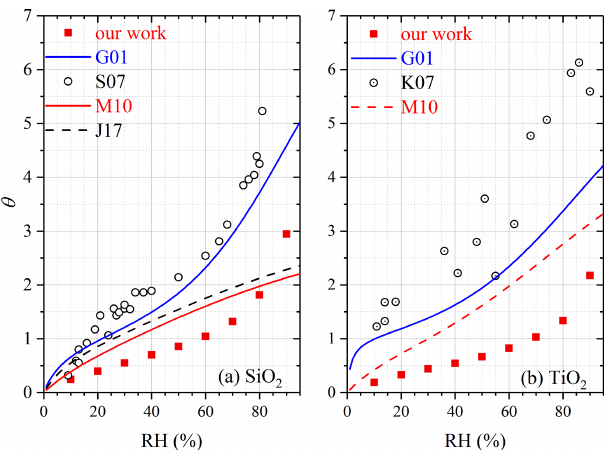
Figure 3. Comparison of surface coverages of adsorbed water ( θ ) measured in our work with those reported in previous studies for (a) SiO 2 and (b) TiO 2 . G01: Goodman et al. (2001); S07: Schuttle- field et al. (2007a); M10: Ma et al. (2010a); J17: Joshi et al. (2017); K07: Ketteler et al.